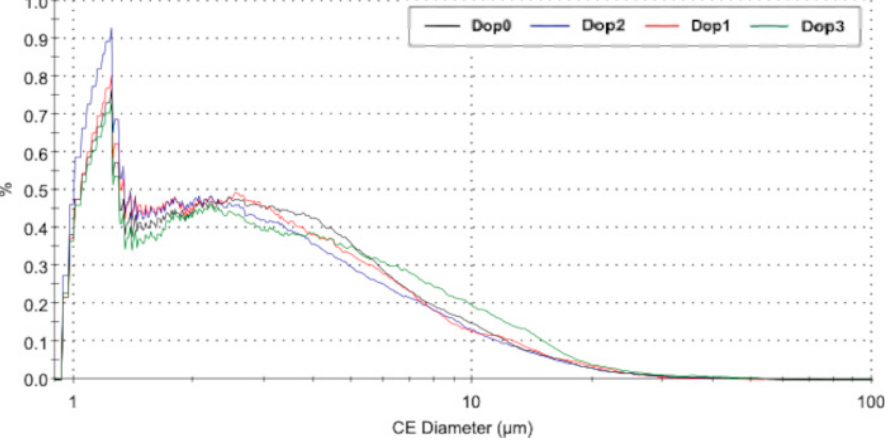
Figure 2. ‘Circle equivalent’ (CE) diameter distribution curves of HAp samples: the curves are obtained from the smoothing by average of 29 readings.